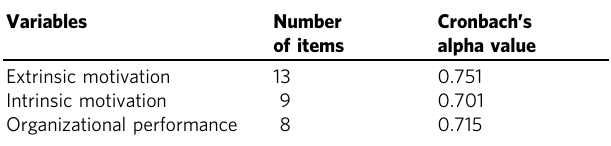
Table 5 Reliability test of variables.